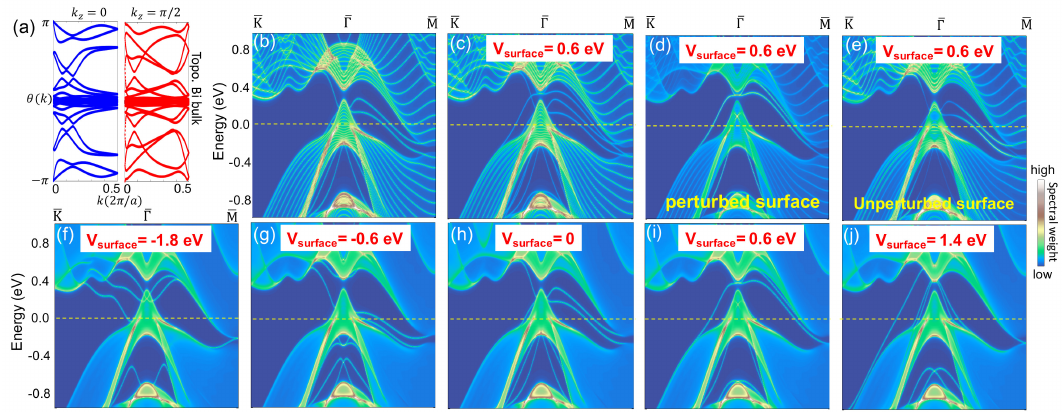
Figure 5. (Color online). ( a ) Wannier charge center evolution in the time-reversal invariant planes of strained Bi. The atomic coordinate along c-axis is stretched by 10%. ( b ) Calculated band structure of a 20L strained Bi(111) film. ( c ) Band structure of a 20L strained Bi(111) with a surface potential 0.6 eV on the top layer. ( d ) Calculated bands of a strained 20L Bi(111) with a surface potential 0.6 eV on the top layer. Each point on the bands is plotted with a weight proportional to the charge density of the corresponding state on the perturbed top layer. ( e ) Same as ( d ) but for the unperturbed bottom layer. ( f – j ) Band spectrum of semi-infinite strained Bi under different surface bias